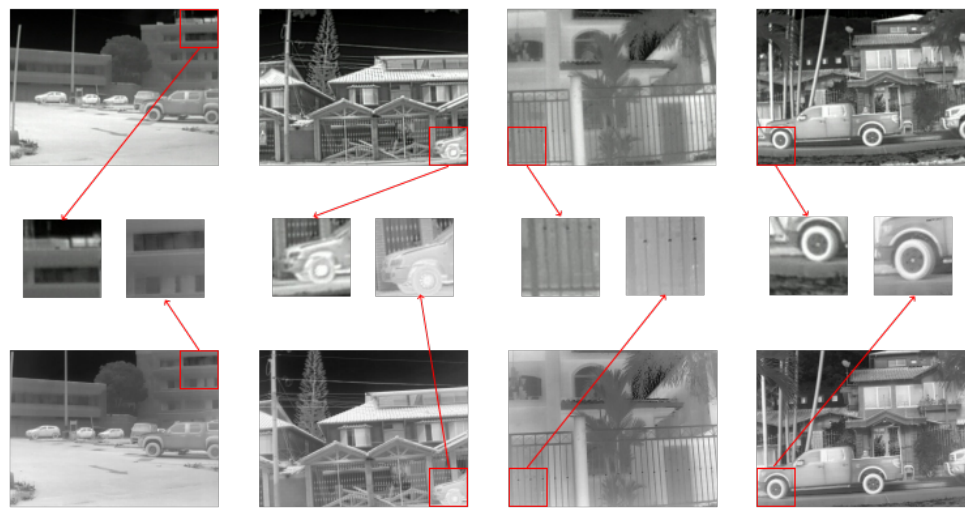
Figure 4. Examples of thermal images from [16]: ( top ) MR images from Axis Q2901-E (320 × 240), used in the current work as LR images; ( bottom ) HR images from FC-6320 FLIR (640 × 480) [16]; ( middle ) enlargements to show the misregistration between the images.